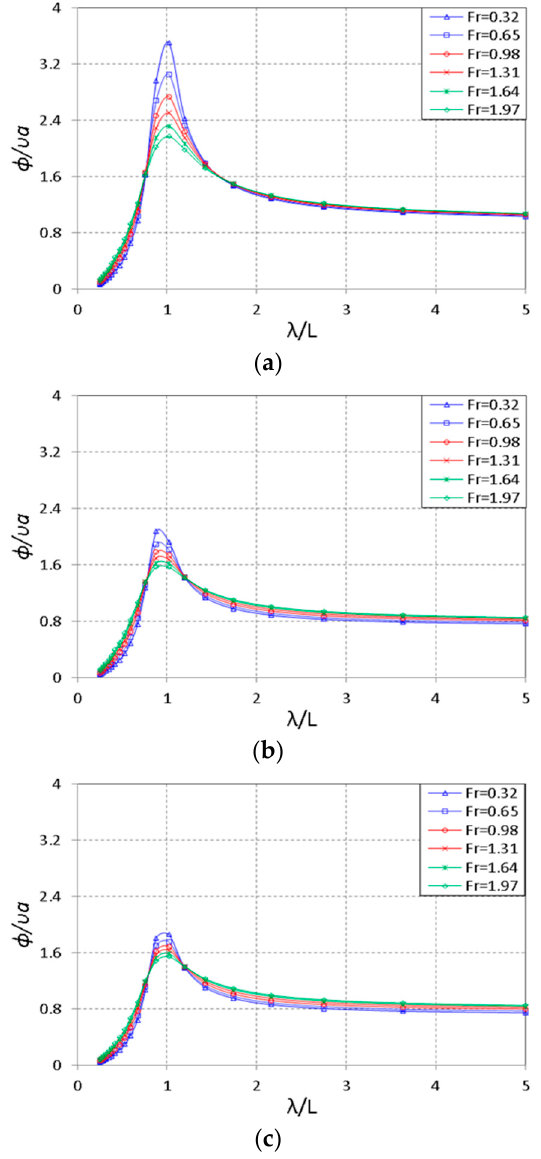
Figure 8. RAO comparison of rolling motion for various Froude numbers at μ = 90° corresponding to trim angles of ( a ) τ = 0°, ( b ) τ = 1°, and ( c ) τ = 2°, respectively.